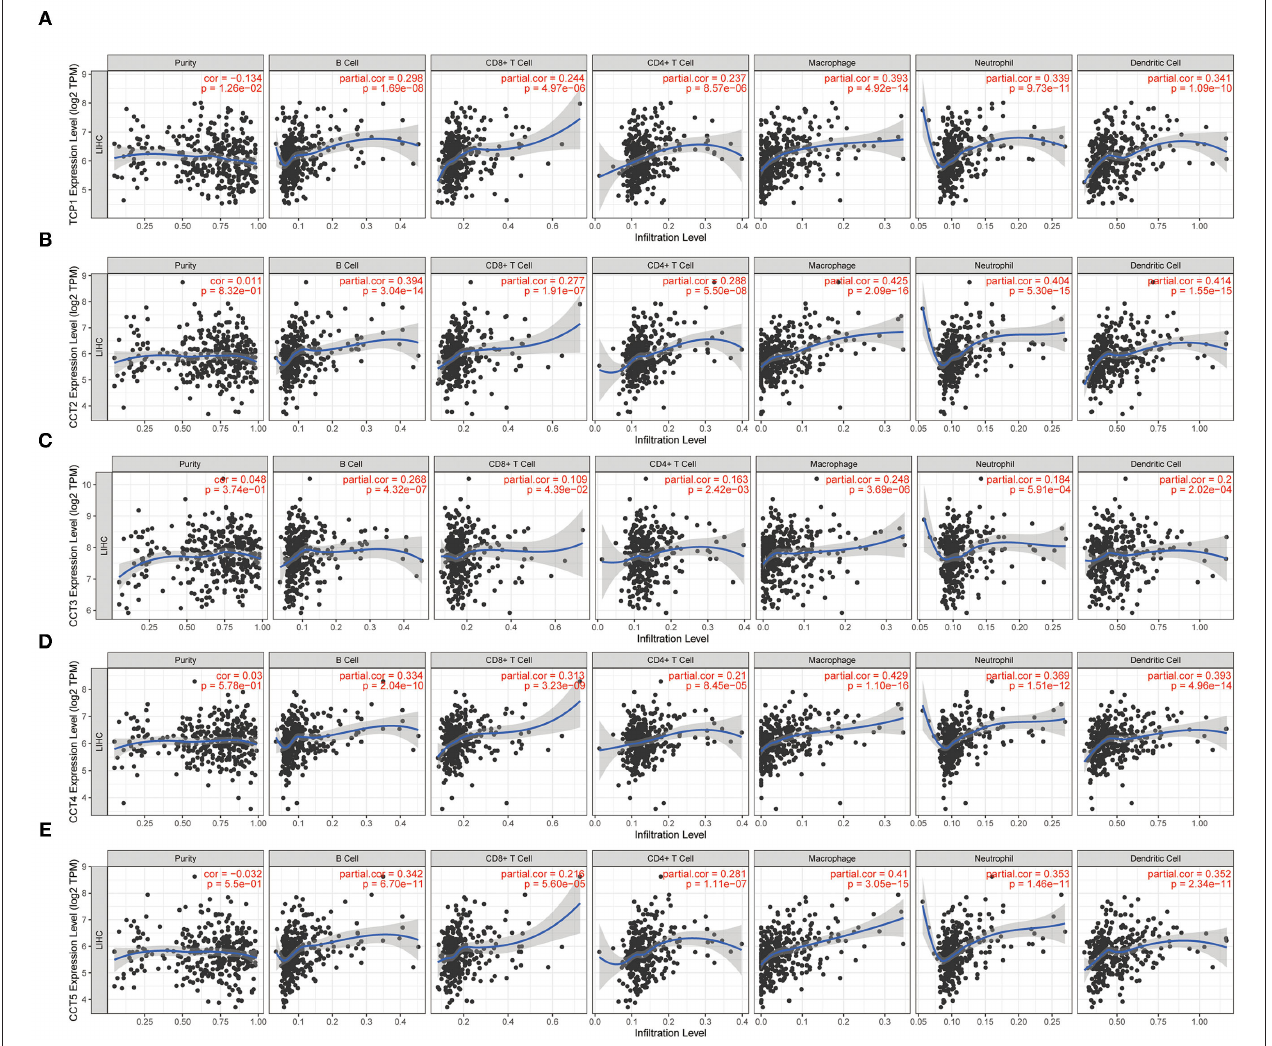
FIGURE 5 | Correlation of immune cell infiltration with TCP1 (A) , CCT2 (B) , CCT3 (C) , CCT4 (D) , CCT5 (E)